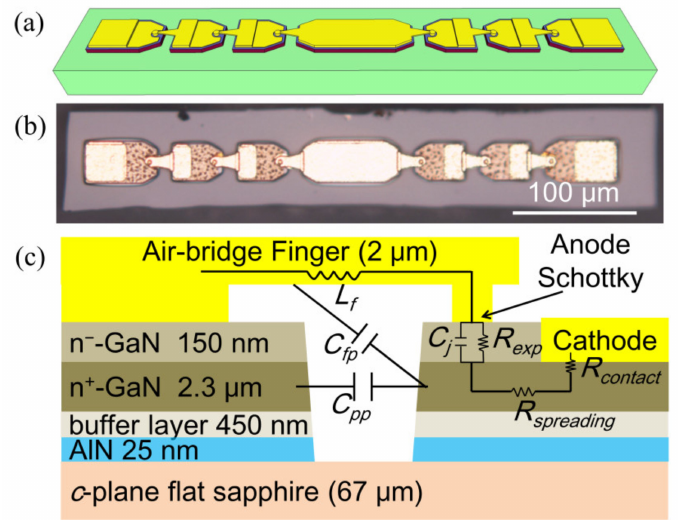
Figure 1. ( a ) The 3D structure of the GaN SBD chain. ( b ) The optical micrograph of the GaN SBD